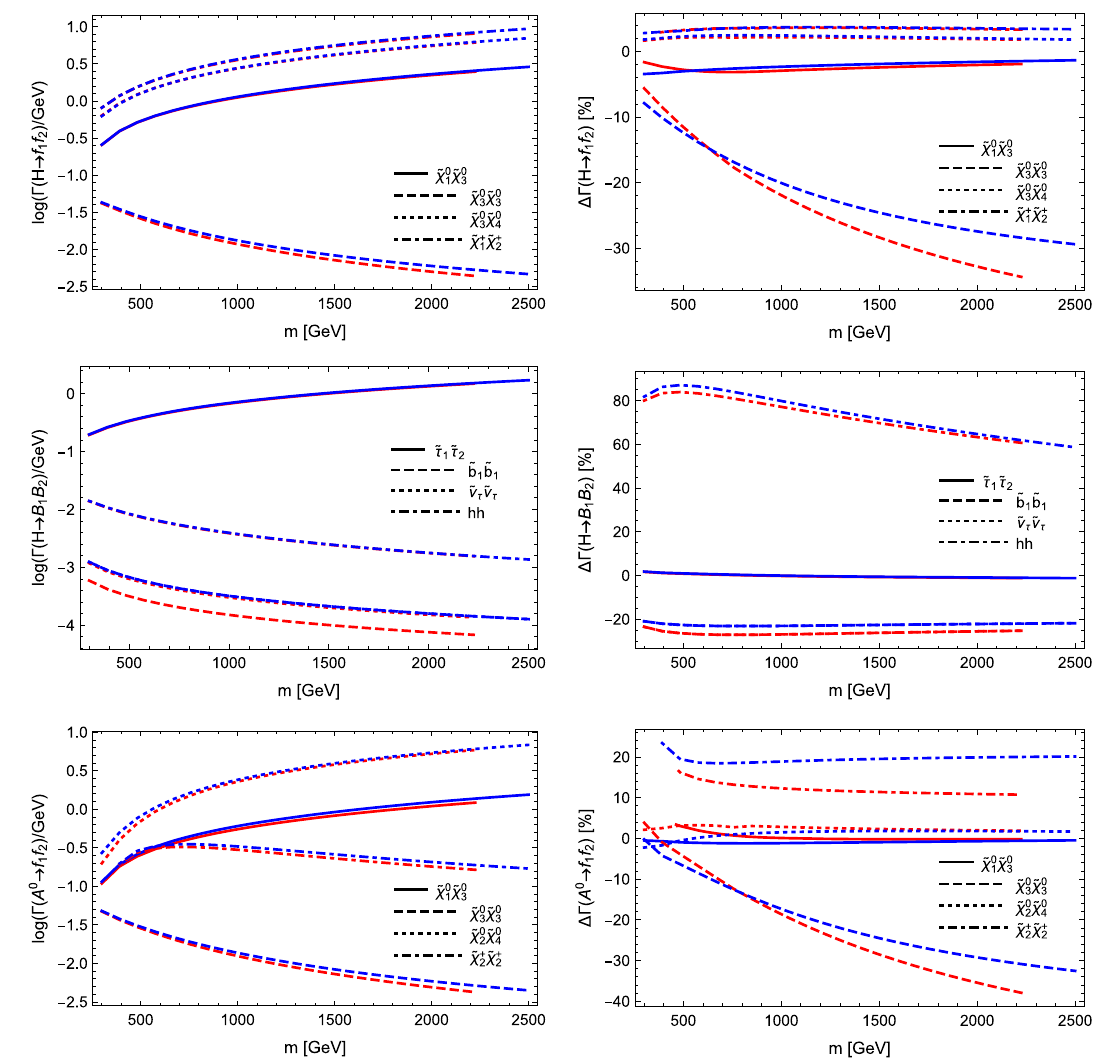
Fig. 7 Comparison between SARAH and HFOLD for the heavy CP -even and -odd Higgs. On the left, the loop-corrected partial widths are shown. On the right, the relative size of the loop correction is given. Blue lines are obtained with SARAH , red lines with